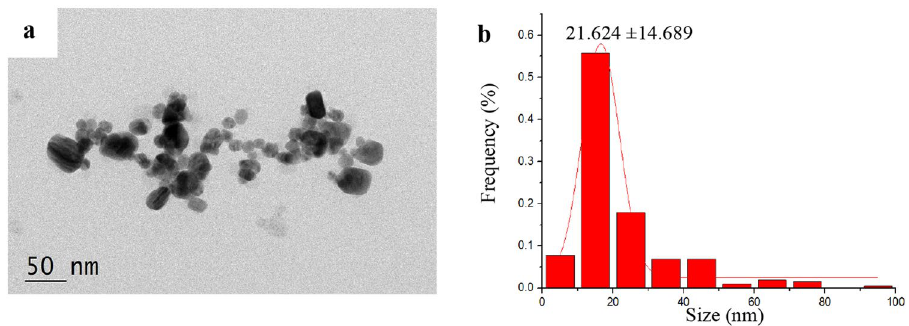
Figure 2. Characterization of silver nanoparticles sizes by TEM. TEM images of AgNPs-PL ( a ) and frequency of size distribution for AgNPs-PL ( b